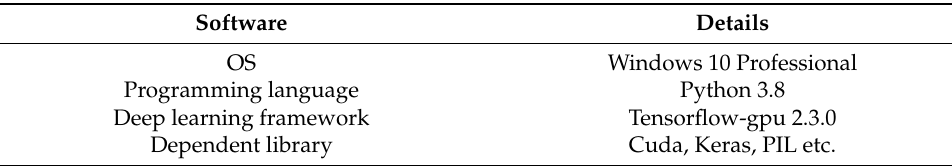
Table 1. Software environment setups employed in this paper.